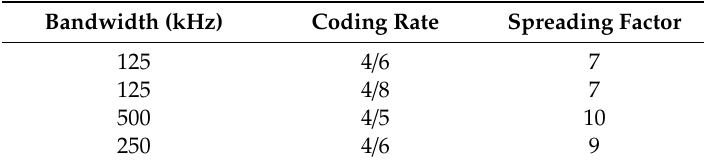
Table 2. Better settings in Experiment